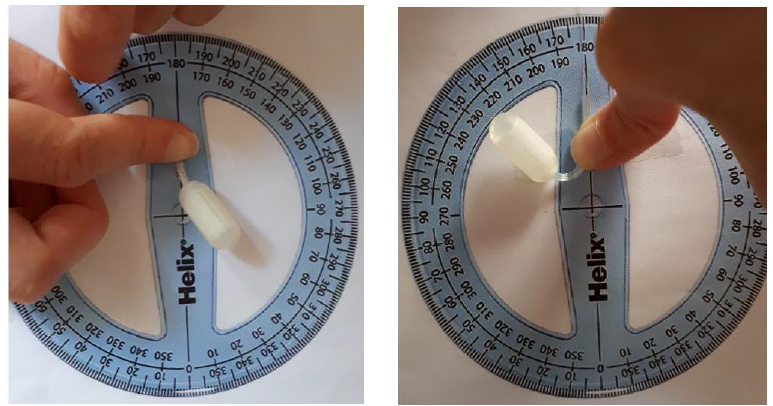
Figure 11. Configuration B: 2-wire mechanism ( left ); 4-wire mechanism ( right ).